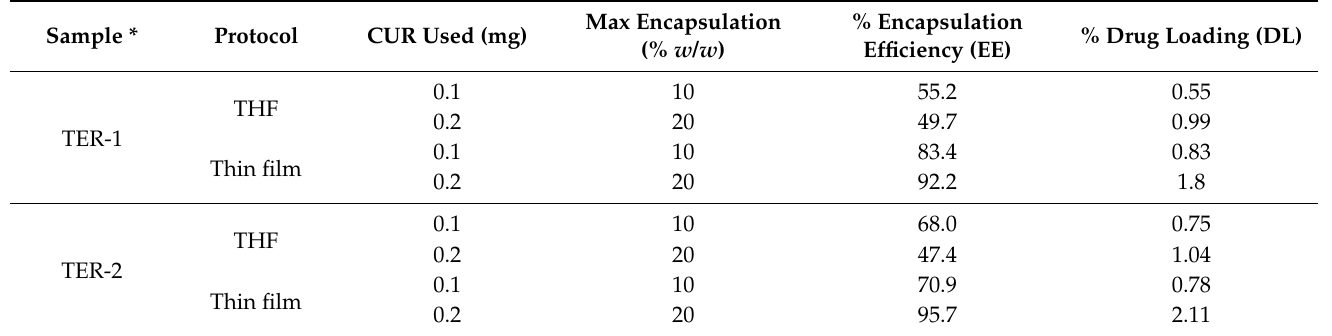
Table 3. Curcumin encapsulation efficiency for P(DMAEMA-co-LMA-co-OEGMA)